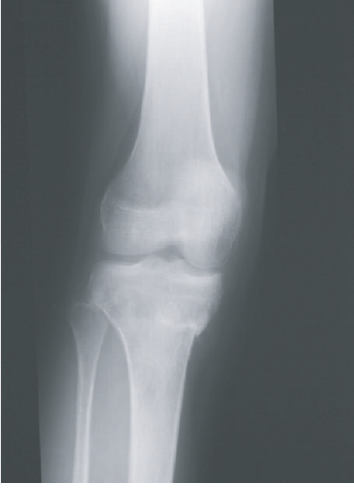
Figure 1: Pathological fracture of right proximal tibia.